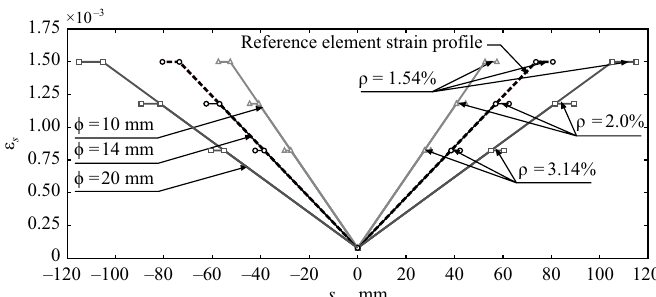
Figure 5. Reinforcement strain distributions over the length between consecutive